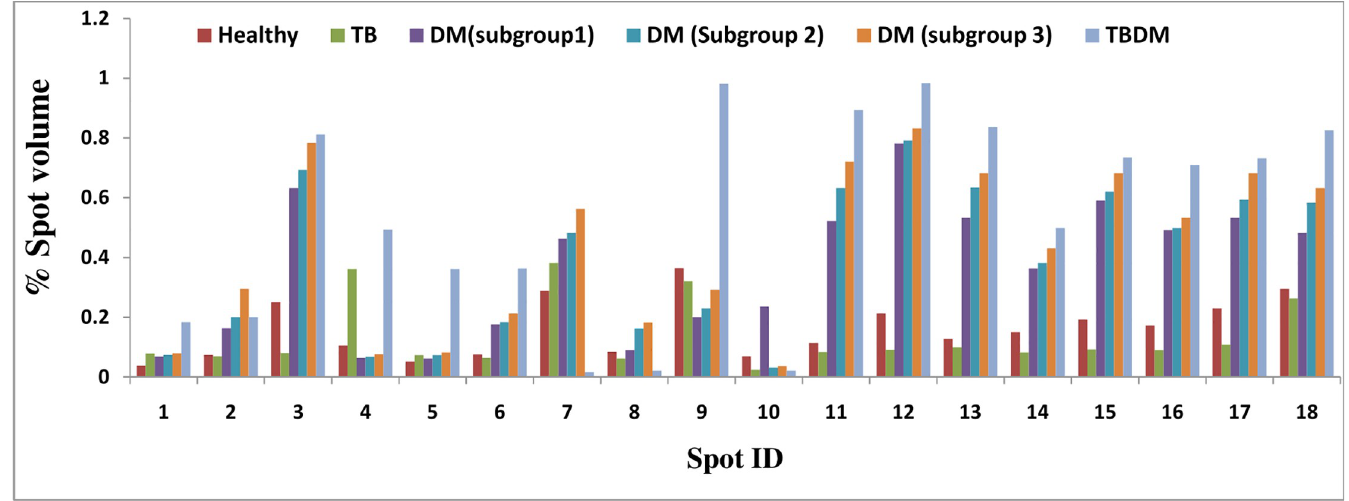
Fig 1. Histogram reflecting differential expression of PBMCs proteins in terms of spot intensity (expressed as % spot volume of at least > 2 fold difference; as compared to healthy controls.